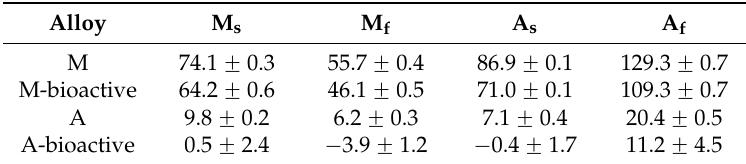
Table 3. Transformation temperatures (°C) for the Ni-Ti studied.